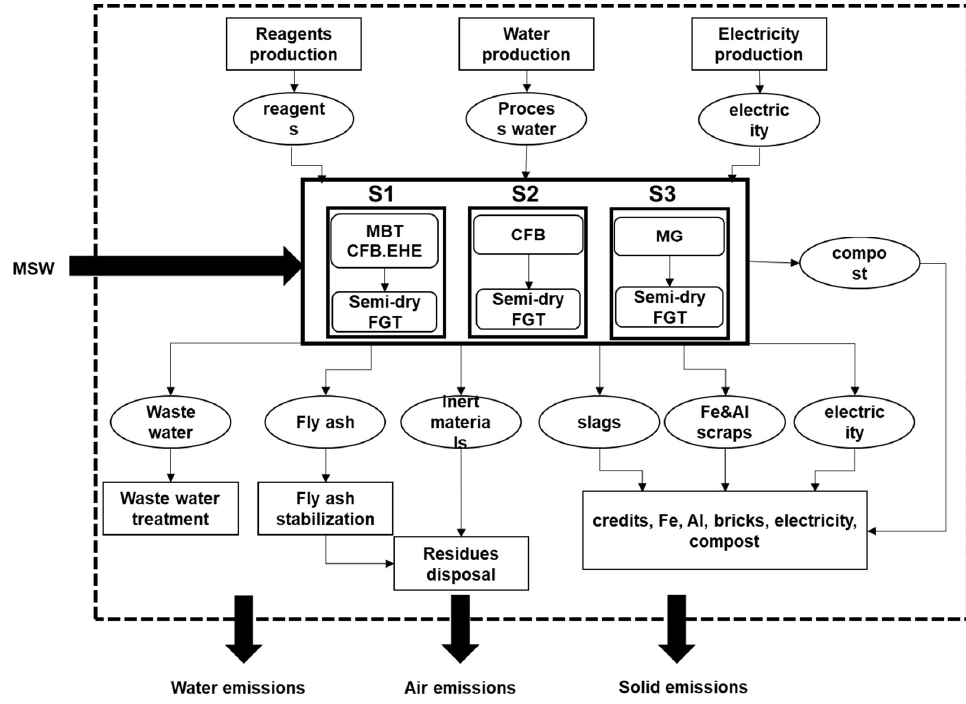
Figure 2. System boundary and flow charts of the considered incineration systems.